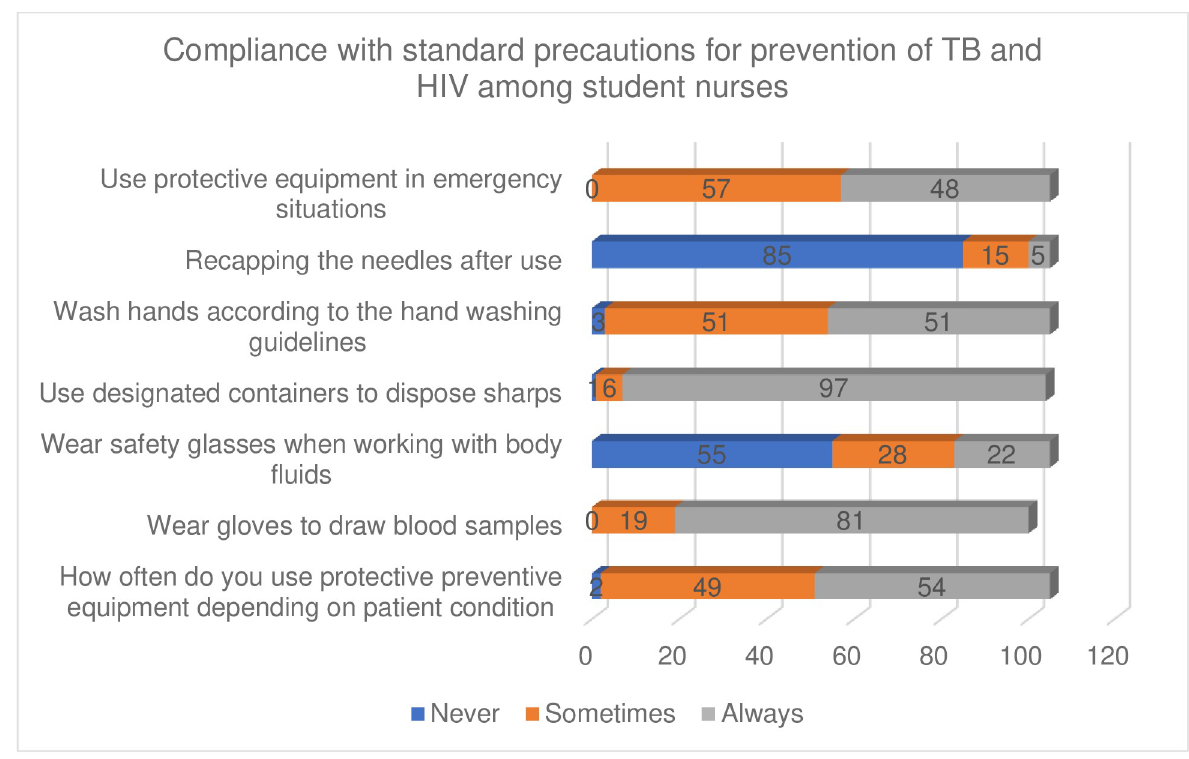
Fig 1. Compliance with standard precautions for prevention of TB and HIV among student